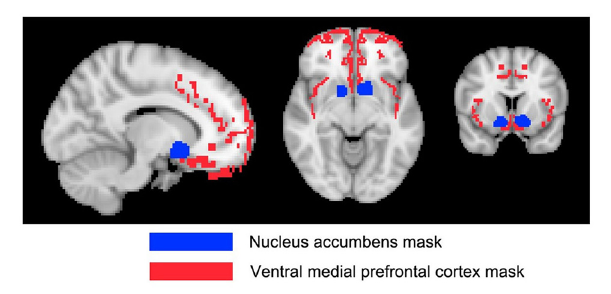
FIGURE 2 | The Rauschecker model brain regions [nucleus accumbens (NAc) and ventromedial prefrontal cortex (vmPFC)] that have been defined as a mask for further analysis.